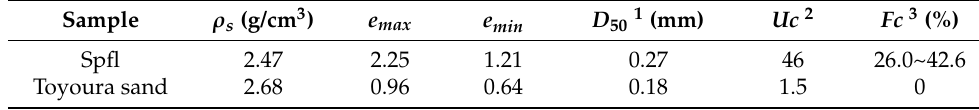
Figure 1. Location of sampling site in this study. Figure 2. Grain size distribution of test samples in this study, according to [27].